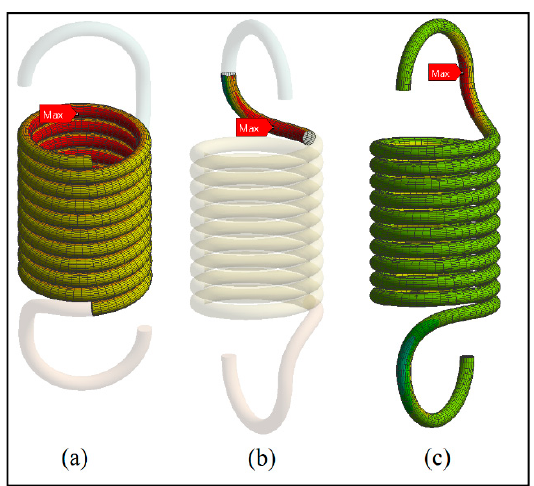
Figure 8. Locations of maximum stress in ( a ) the body, ( b ) point B and ( c ) point A.